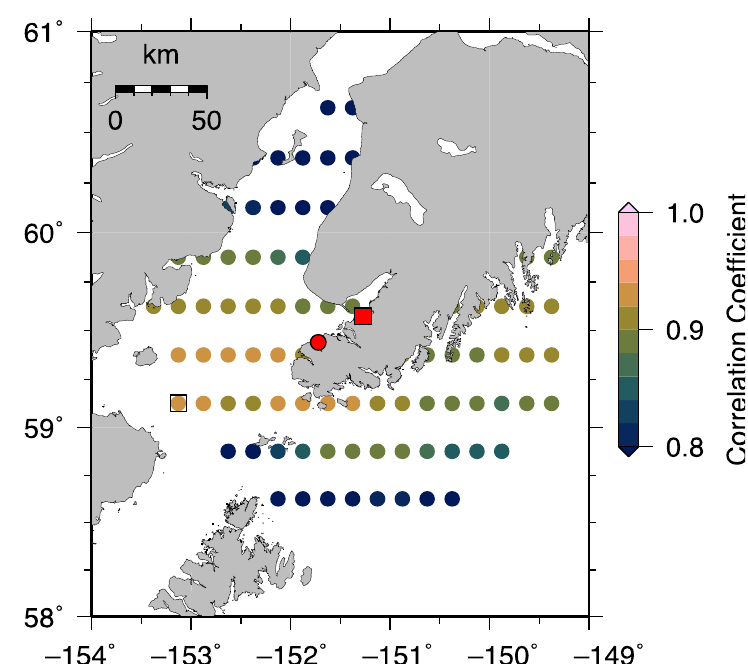
Figure A5. Same as Figure 5 but for BRST.